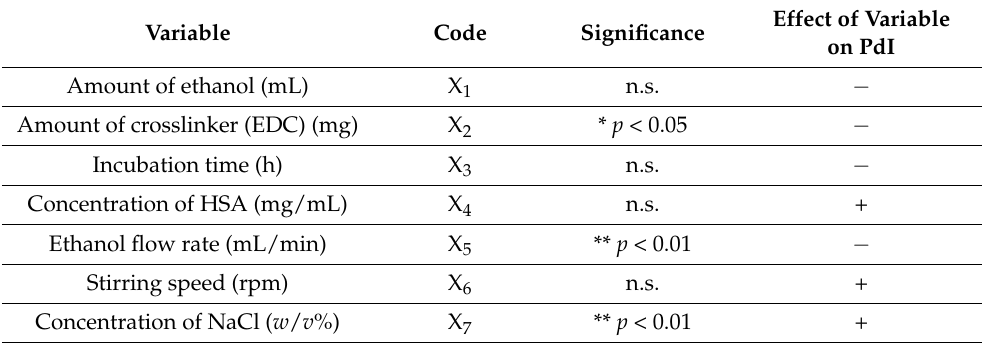
Table 6. Effect of the 7 investigated process and material parameters on the PdI of HSA nanoparti- cles produced by the rapid coacervation method. Statistical analysis: One-way ANOVA, α = 0.05. (* p < 0.05; ** p < 0.01 significant, while n.s. means non-significant effect). Effect of Variable Variable Code Significance on PdI Amount of ethanol (mL) X 1 n.s. − Amount of crosslinker (EDC) (mg) X 2 * p < 0.05 − Incubation time (h) X 3 n.s. − Concentration of HSA (mg/mL) X 4 n.s. + Ethanol flow rate (mL/min) − Stirring speed (rpm) + Concentration of NaCl ( w / v %) X